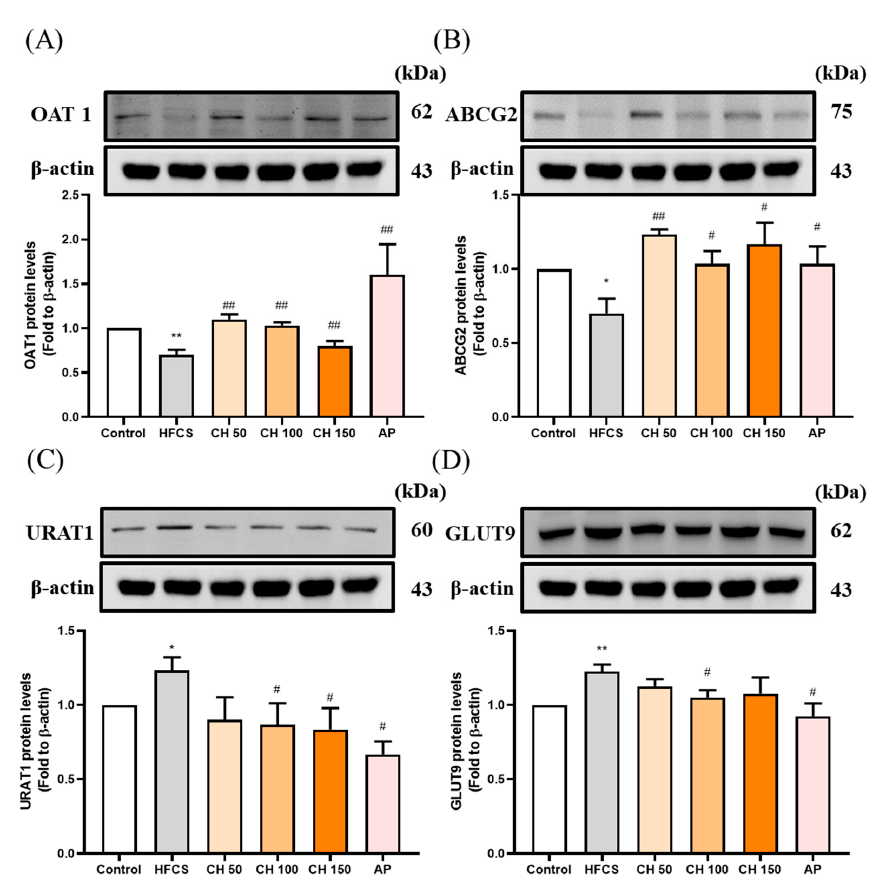
Figure 4. Effects of chrysin on urate-related transporter proteins expressions ( A ) OAT1, ( B ) ABCG2, ( C ) URAT1, and ( D ) GLUT9 in the kidney of hyperuricemic rats. C: control; HFCS: high-fructose corn syrup group (10% high-fructose corn syrup solution); AP: Allopurinol (10 mg/kg bw); CH 50: chrysin (50 mg/kg bw); CH 100: chrysin (100 mg/kg bw); CH 150: chrysin (150 mg/kg bw). Data are represented as mean ± SEM ( n = 4–6 per group ). * p < 0.05, ** p < 0.01 versus the control group. # p < 0.05, ## p < 0.01 versus the HFCS group.